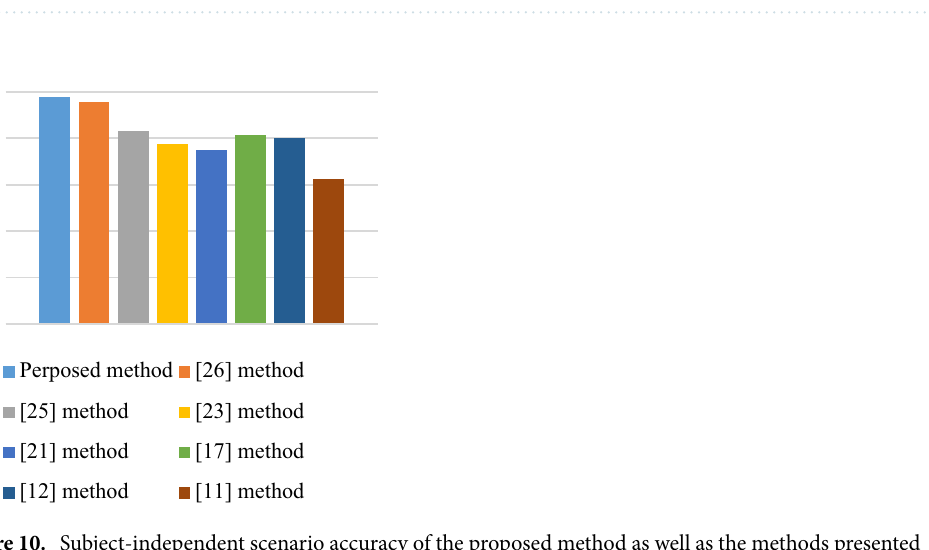
Figure 9. Subject-dependent scenario accuracy of the proposed method as well as the methods presented in methods 11,12,17,21,23,25,26 for recorderd EEG.